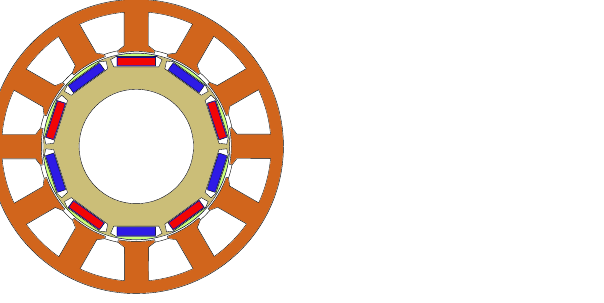
Figure 4. Geometry of the 12-slot/10-pole IPM machine considered in this paper. Table 2. The considered manufacturing uncertainties and the corresponding ranges.